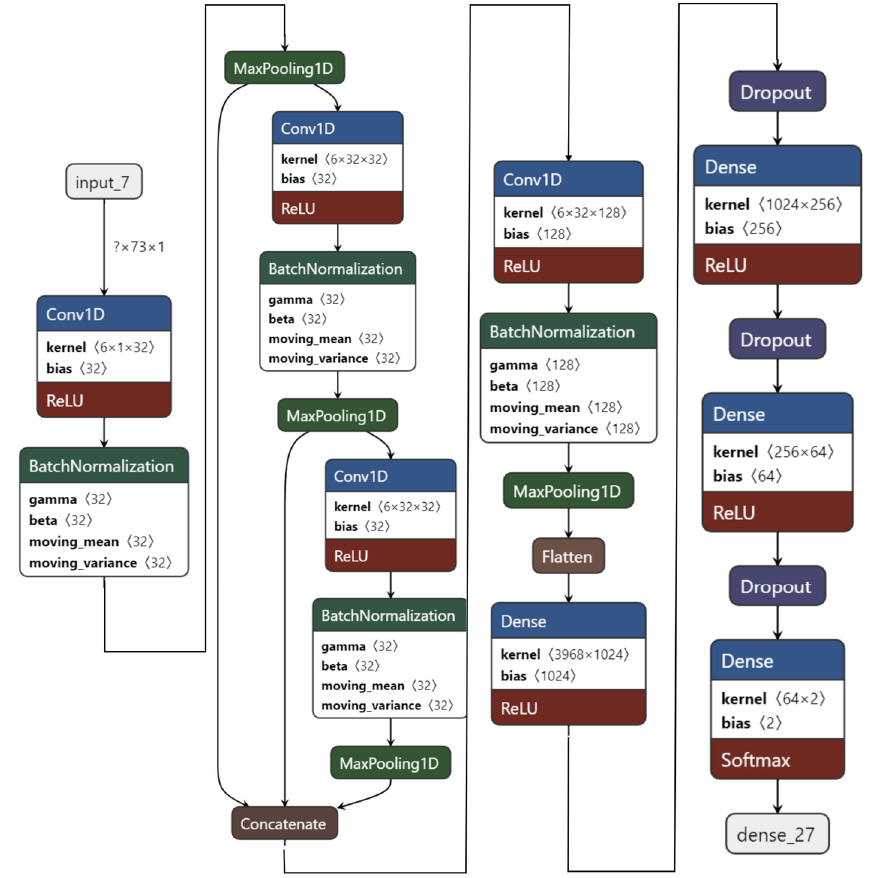
Figure 7. M1 Model: 1D CNN model with 4 convolution and 3 dense layers.